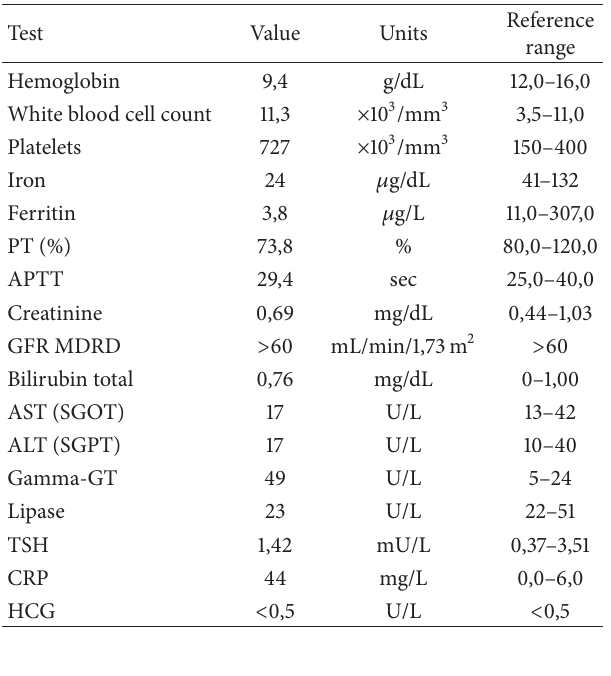
Table 1: Biochemical values at time of admission.